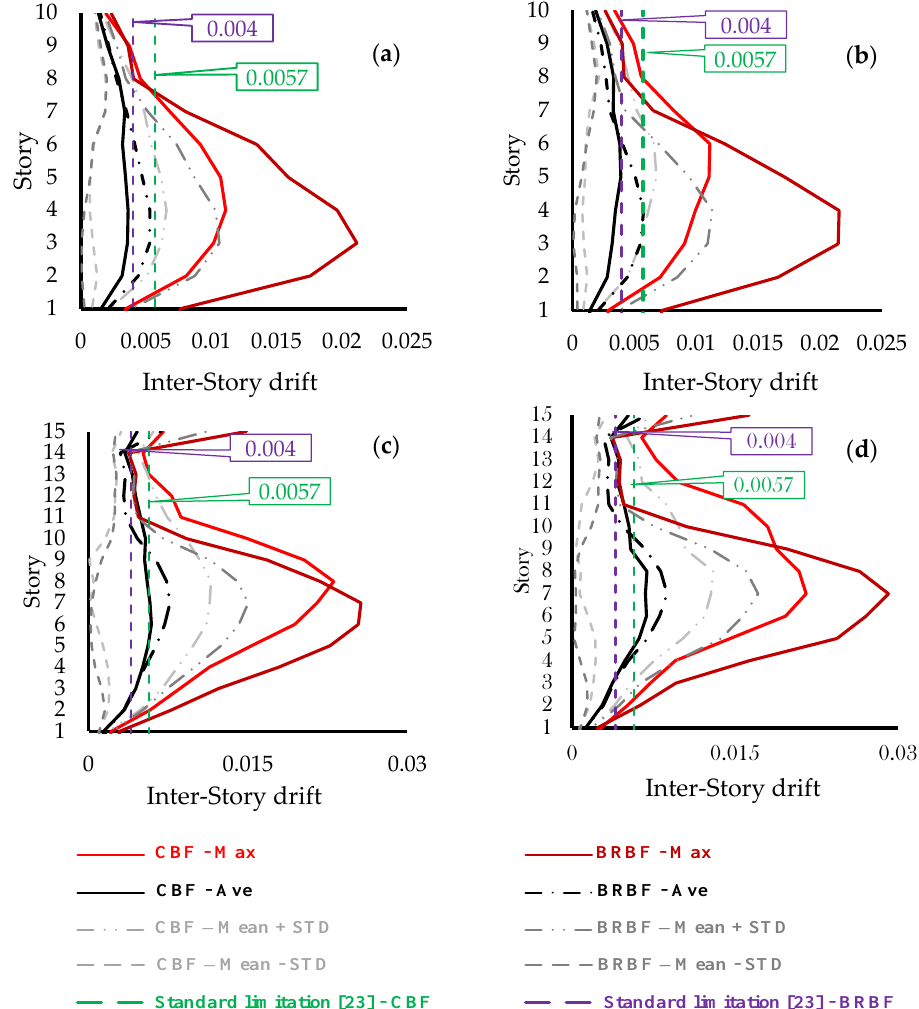
Figure 5. Inter-story drift of ( a ) 10-story regular frames, ( b ) 10-story mass irregularity frames, ( c ) 15-story regular frames and ( d ) 15-story mass irregularity frames.